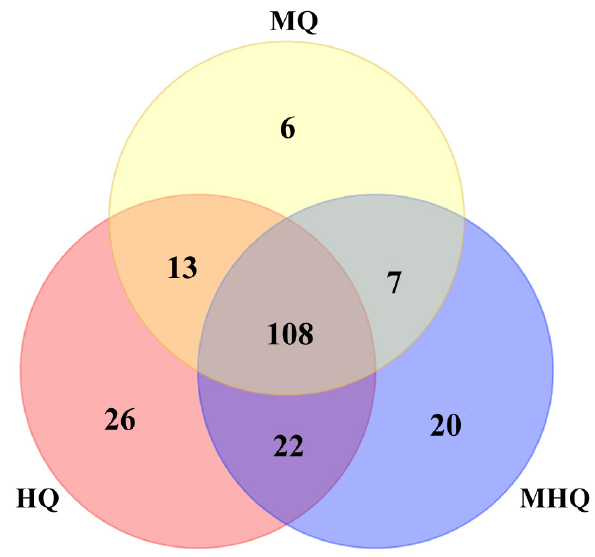
Figure 5. Venn diagram of the fungal community in different mature Daqu. MQ: Medium-temperature Daqu, MHQ: Medium-high-temperature Daqu, and HQ: High-temperature Daqu.